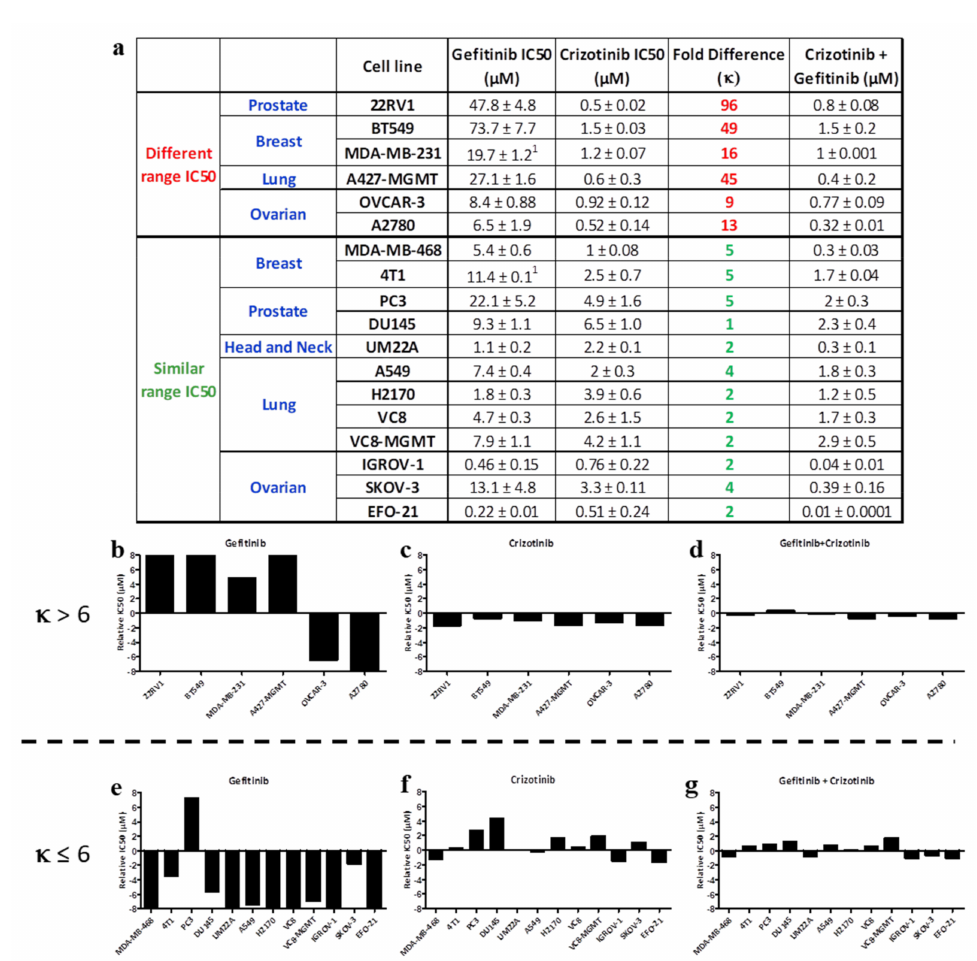
Figure 2. ( a ) IC50 values of tumor cell growth inhibition on a panel of human cancer cell lines using gefitinib, crizotinib (c-Met kinase inhibitor), and their equimolar combination. The fold difference between the IC50 values of the two individual drugs is denoted by κ . ( b – g ) Relative IC50 values (IC50 of individual drug minus the average IC50 of the drug on the entire panel of cell lines) of gefitinib, crizotinib, and their equimolar combination for ( b – d ) κ > 6, and ( e – g ) κ ≤ 6. 1 Rao et al. 2015